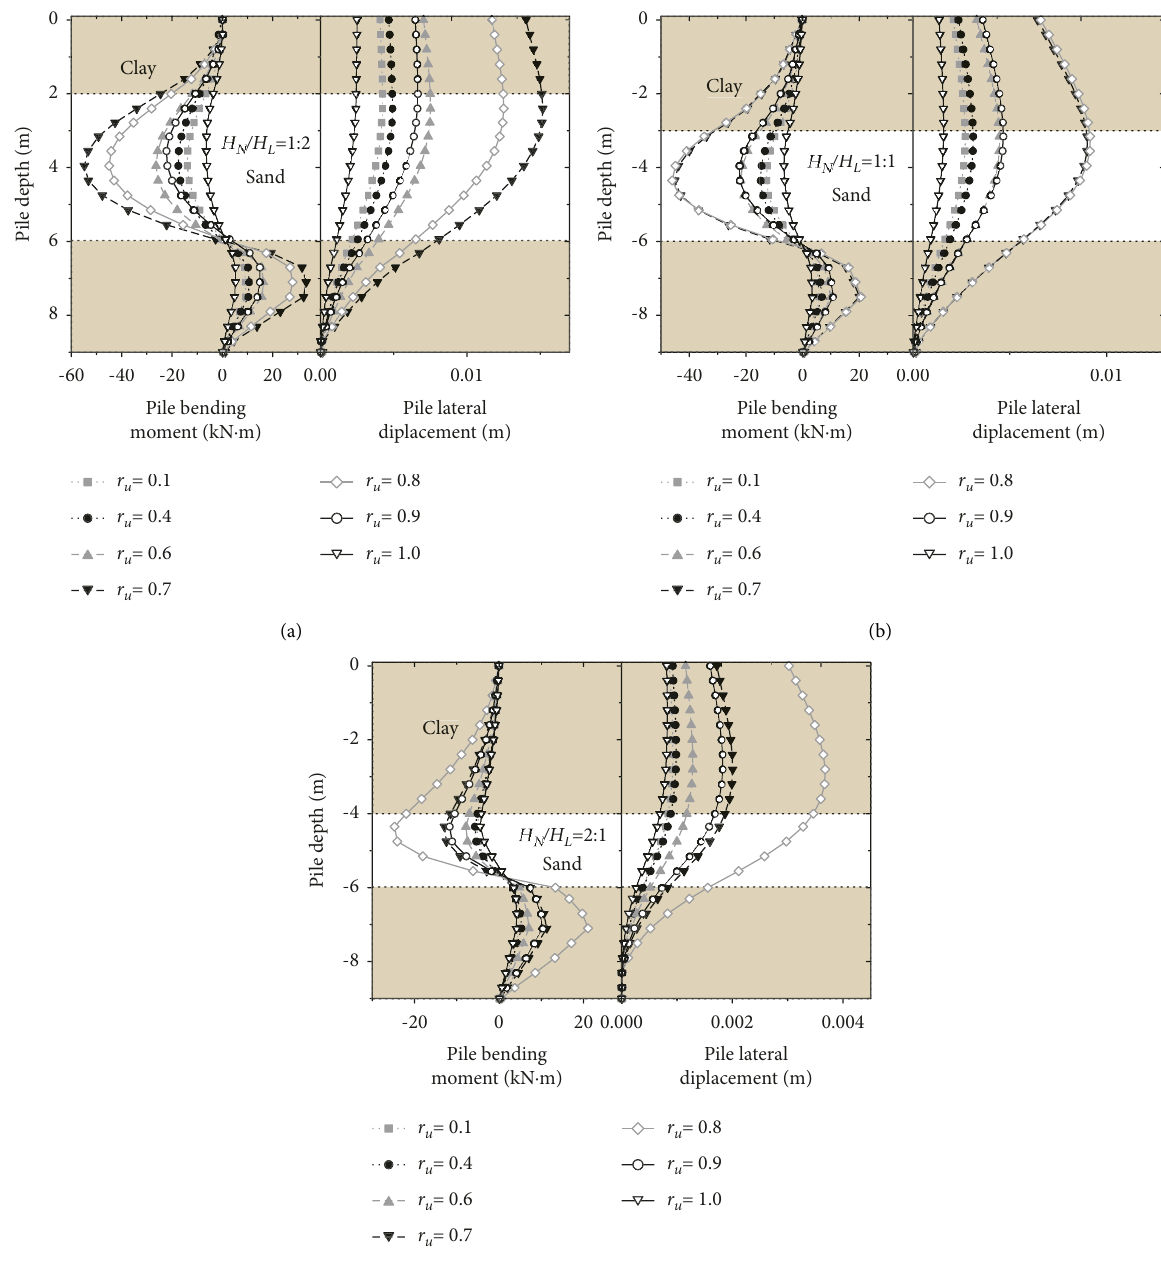
Figure 9: The bending moment and lateral displacement of pile under the foundations with different H H L � 1 :1; (c) H N / H L �